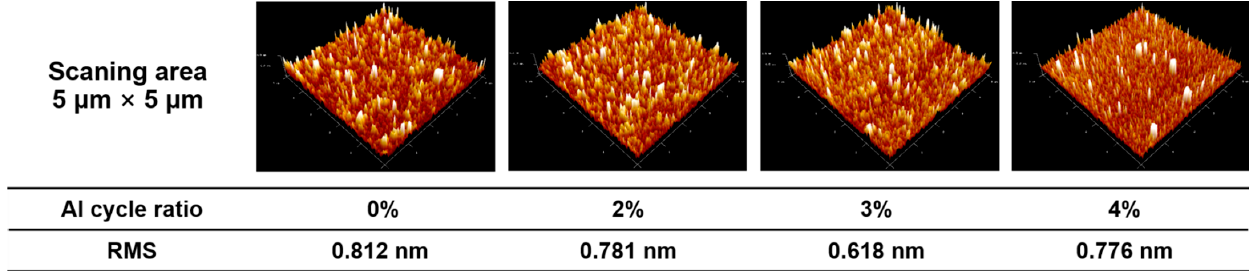
Figure 6. 3D AFM images of ZnO and AZO films. Al cycle ratio and RMS are list below 3D AFM images. ZnO and AZO films were deposited on silicon substrates.